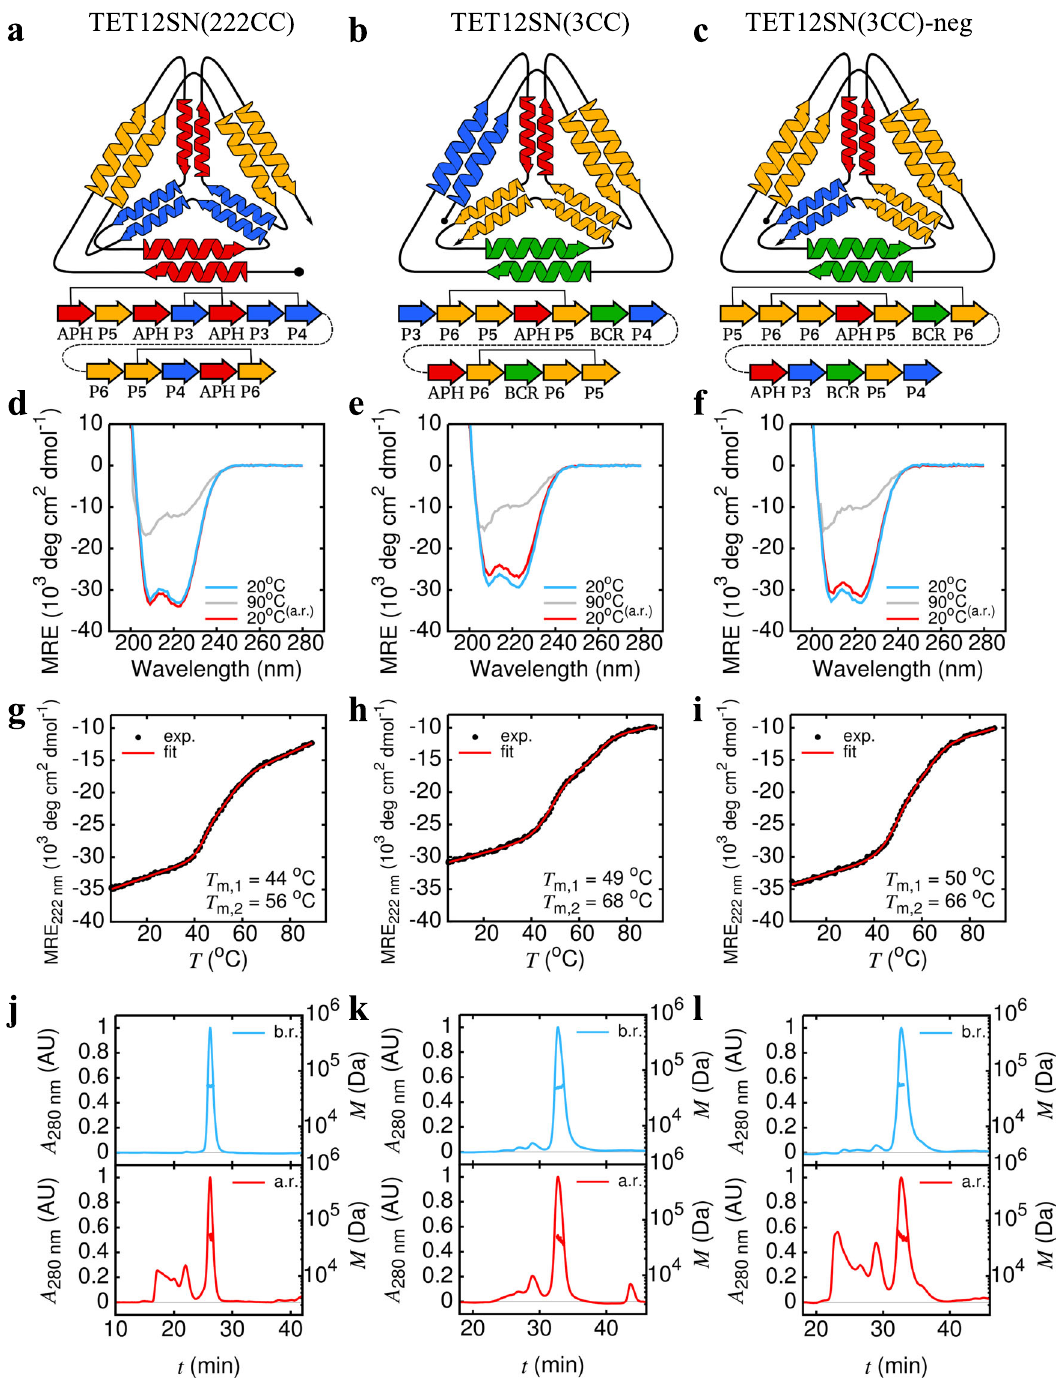
Fig. 4 Biophysical characterisation of tetrahedral protein cages with three duplications or a single triplication of the same CC building module. Schematic depiction of designed CCPO cages. TET12SN(222CC) ( a ) comprises two copies of coiled-coil pairs P5SN:P6SN, P3SN:P4SN and APHSN. TET12SN(3CC) ( b ) and TET12SN(3CC)-neg ( c ) on the other hand contain three instances of P5SN:P6SN in their amino acid sequence. For repeating CC modules, on-target peptide pairings are indicated with a solid black line. d – f Circular dichroism (CD) spectra at 20 °C (blue), 90 °C (grey) and 20 °C after denaturation and rapid refolding (red). CD signal was converted to mean residue ellipticity (MRE) to facilitate comparison. g – i Temperature denaturation was monitored with CD at 222 nm. In all cases, the denaturation curve was characterised by two transitions. Melting temperatures associated with each transition ( T m,1 and T m,2 ) were determined using a three-state model. j – l SEC-MALS analysis before (blue) and after (red) temperature denaturation revealed a high degree of aggregation after refolding for TET12SN(3CC)-neg. Elution pro fi les were monitored by UV absorbance at 280 nm ( A 280 nm ). Molecular weight ( M ) was determined from light scattering. Source data are provided as a Source Data fi le.